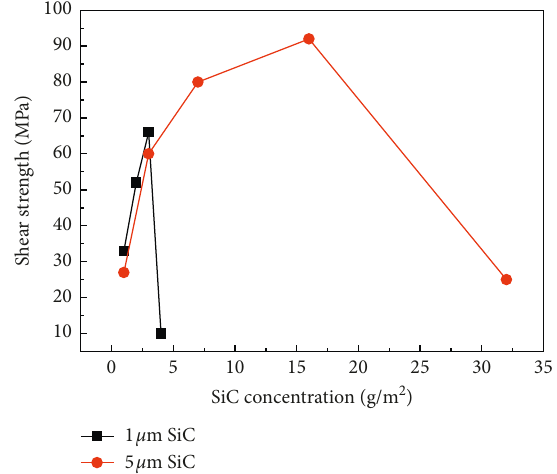
Figure 6: Shear strength of the joint at different SiC